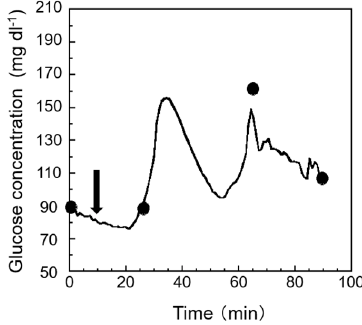
Figure 6. Monitoring stress response to air exposure. Glucose concentrations in the EISF, plotted as the first black circles, were used for the one-point calibration method. All other black circles indicate the blood glucose concentration that is described in Section 2.6.1. The arrows in the figure indicate points where air exposure (15 min) has started.